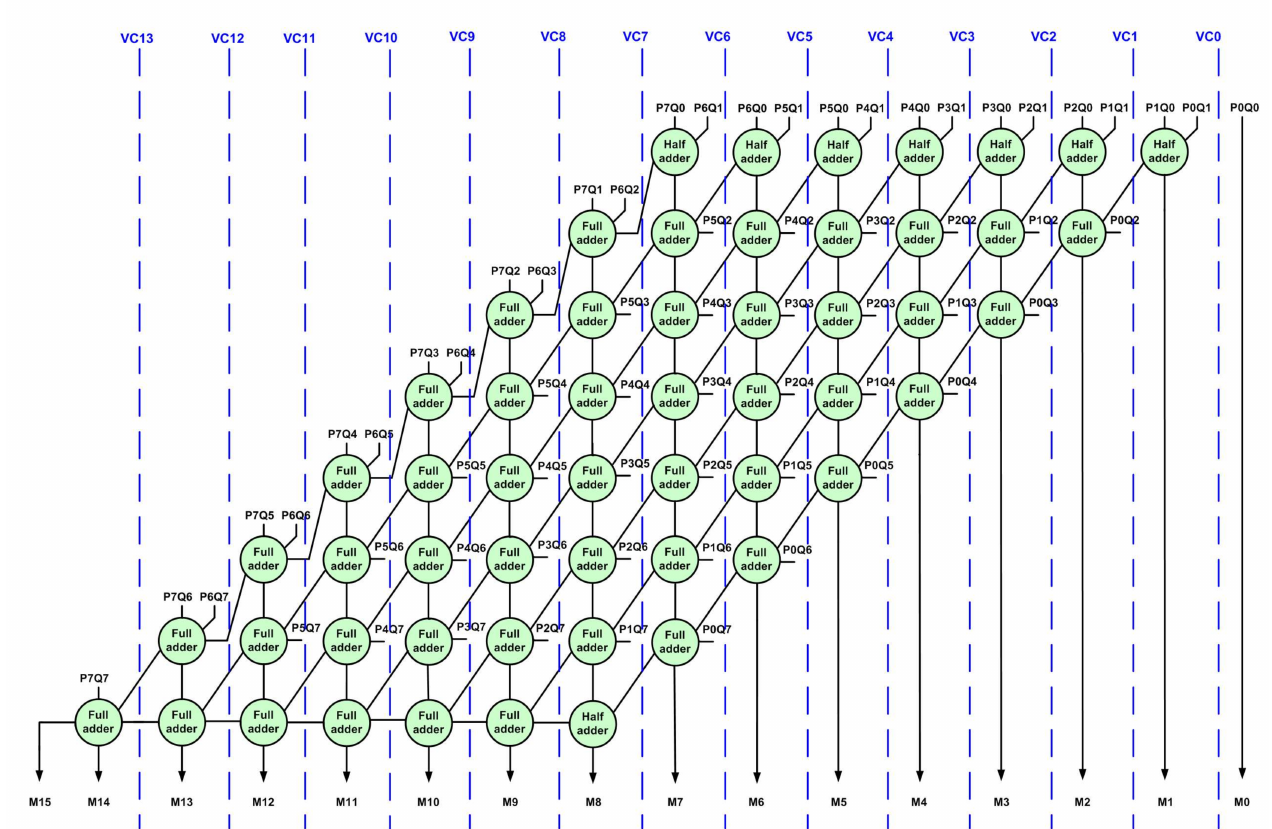
Figure 1. Architecture of an 8 × 8 exact array multiplier (EAM). Example vertical cuts VC0 up to VC13, any of which could be made on an EAM to generate an inexact array multiplier (IAM), are shown as blue dashed